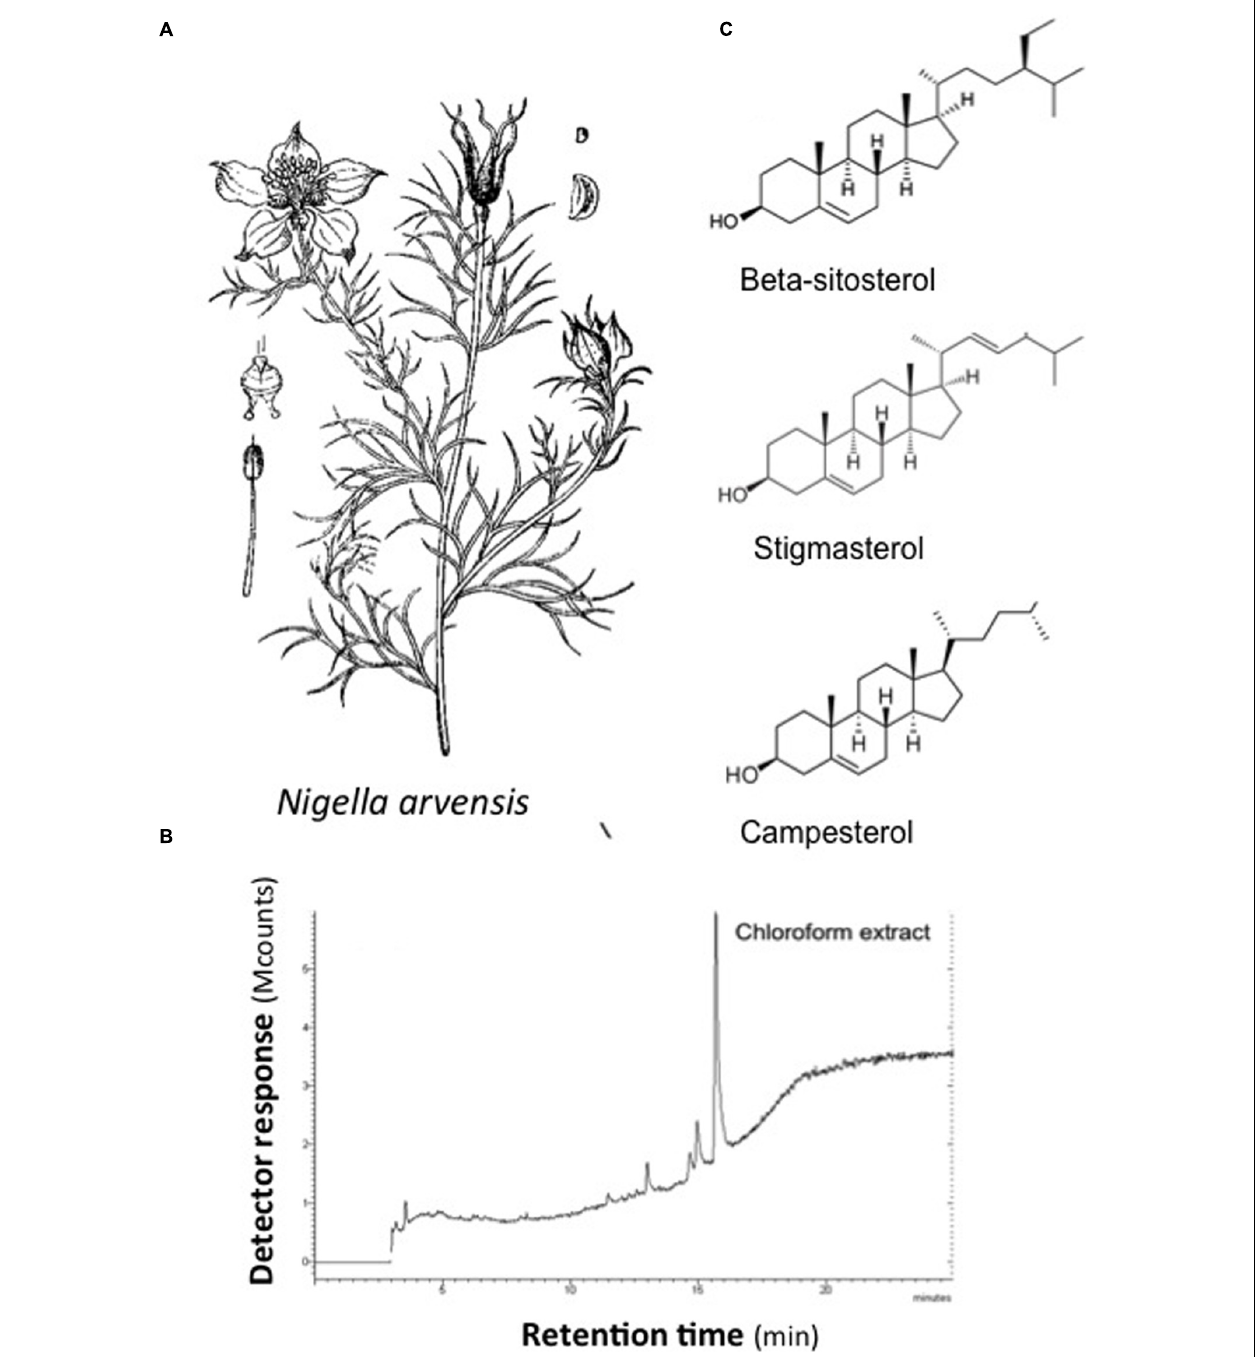
FIGURE 1 | Chemical structures of major compounds identified in extracts from Nigella arvensis. (A) N. arvensis. (B) GC/MS profile of chloroform extract. (C) Chemical structures of β -sitosterol, stigmasterol, and campesterol.